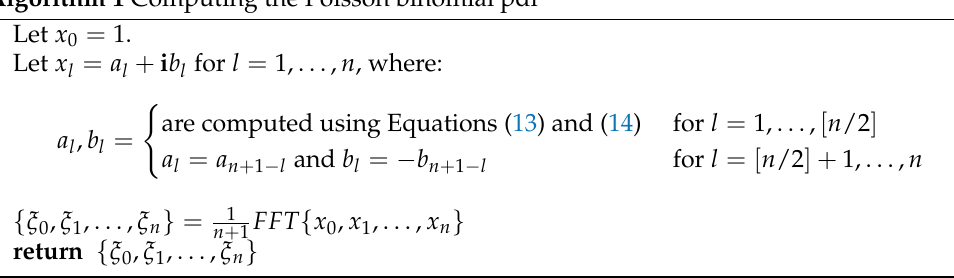
Algorithm 1 Computing the Poisson binomial